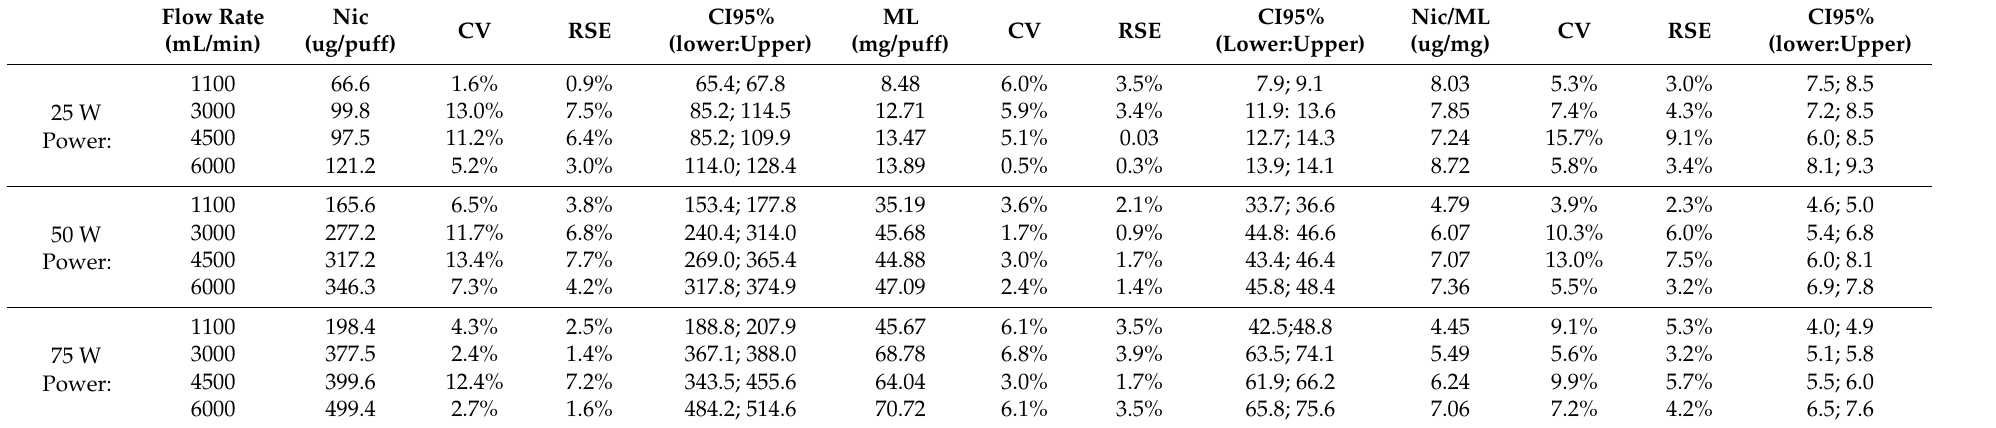
Table 2. Summary of nicotine yield per puff and vapor